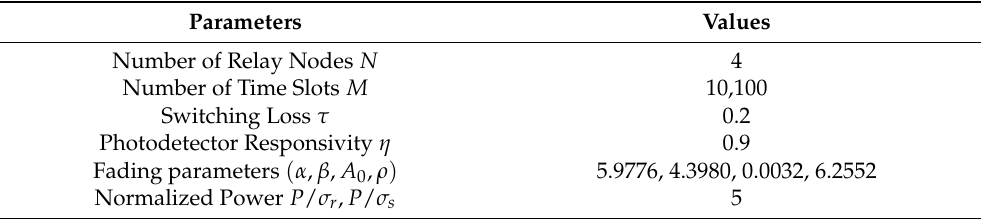
Table 1. Simulation